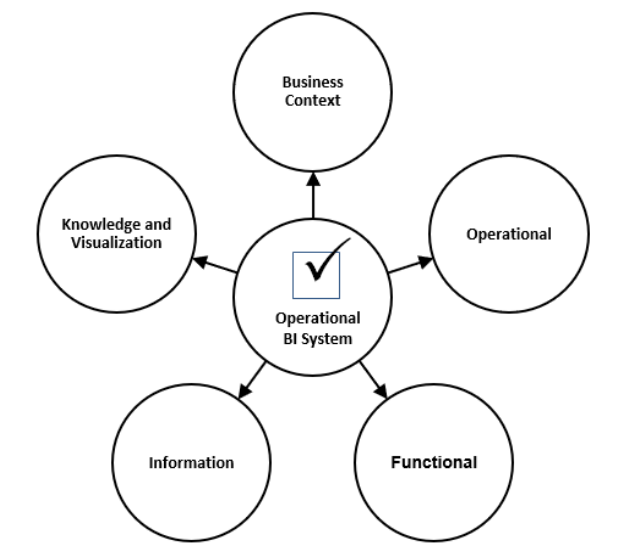
Fig. 4 Categories of Operational BI